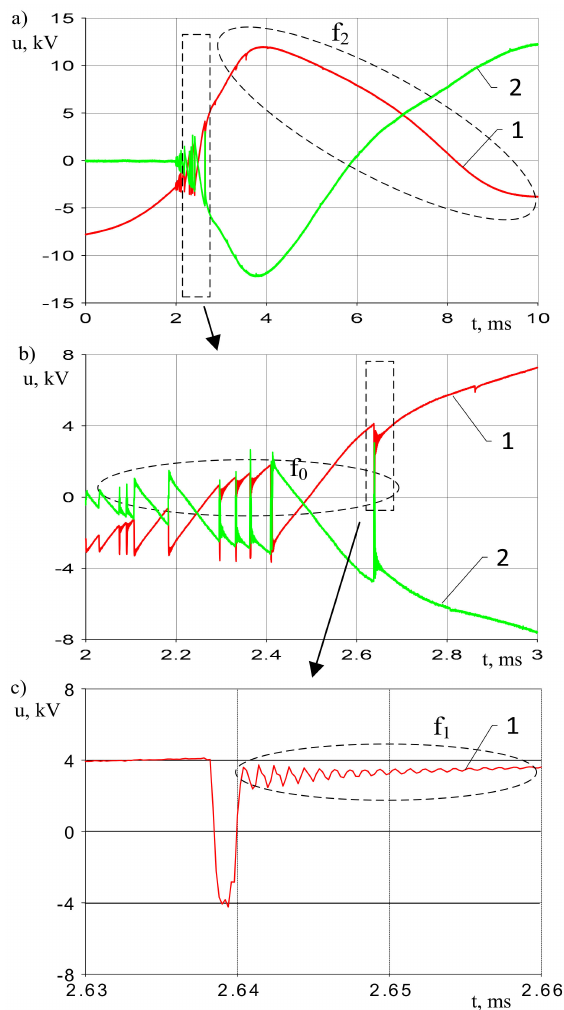
Figure 6. Transient phase voltage waveforms at the transformer terminals Tr, switched o ff with a vacuum circuit breaker W, connected to the transformer by a 85 m long cable line lc in a single-phase system and voltage between the contacts of the circuit breaker wb (Figure 3): ( a )—voltage waveforms in 10 ms time window; ( b , c )—parts of the diagram from Figure 6a: 1—phase voltage across the transformer Tr, 2—voltage between the contacts of the vacuum circuit-breaker